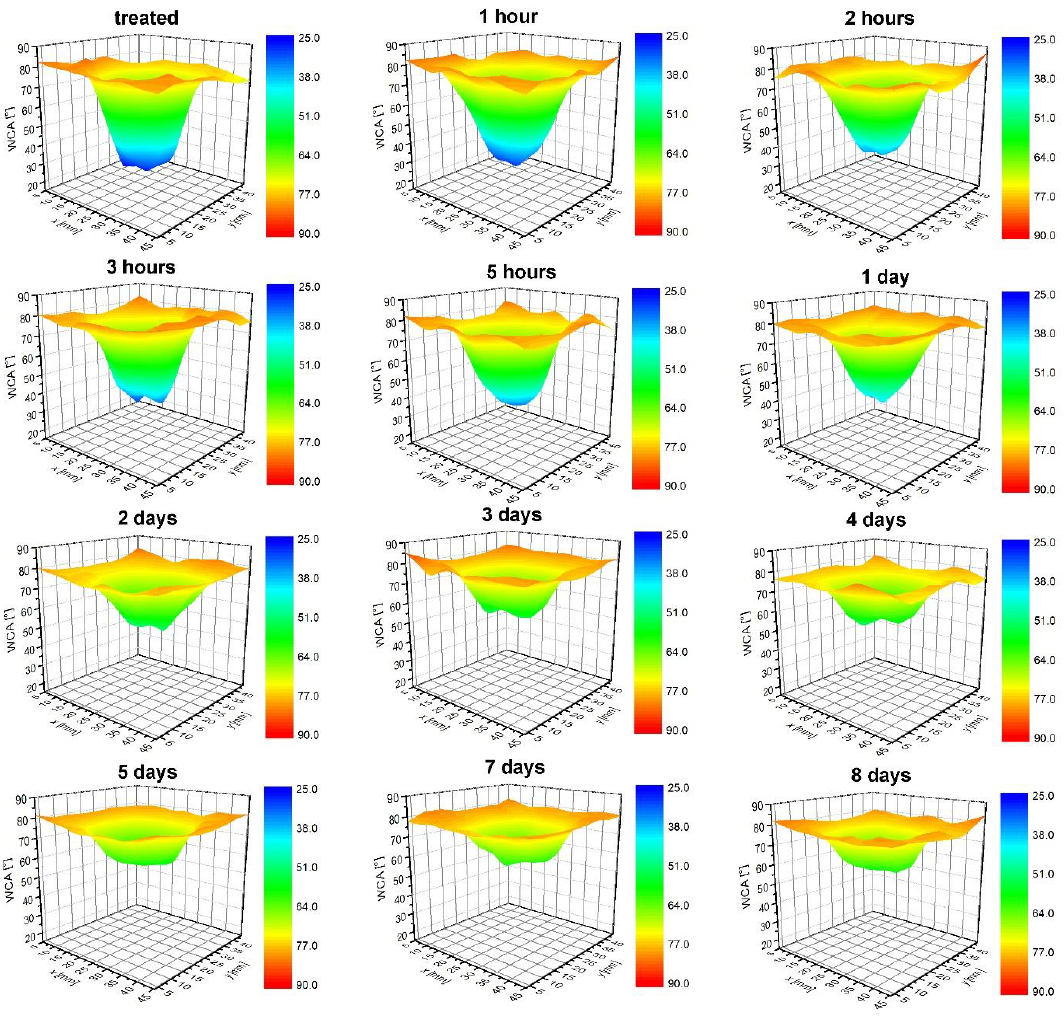
Figure 12. 3D evolution of water contact angles versus aging time.